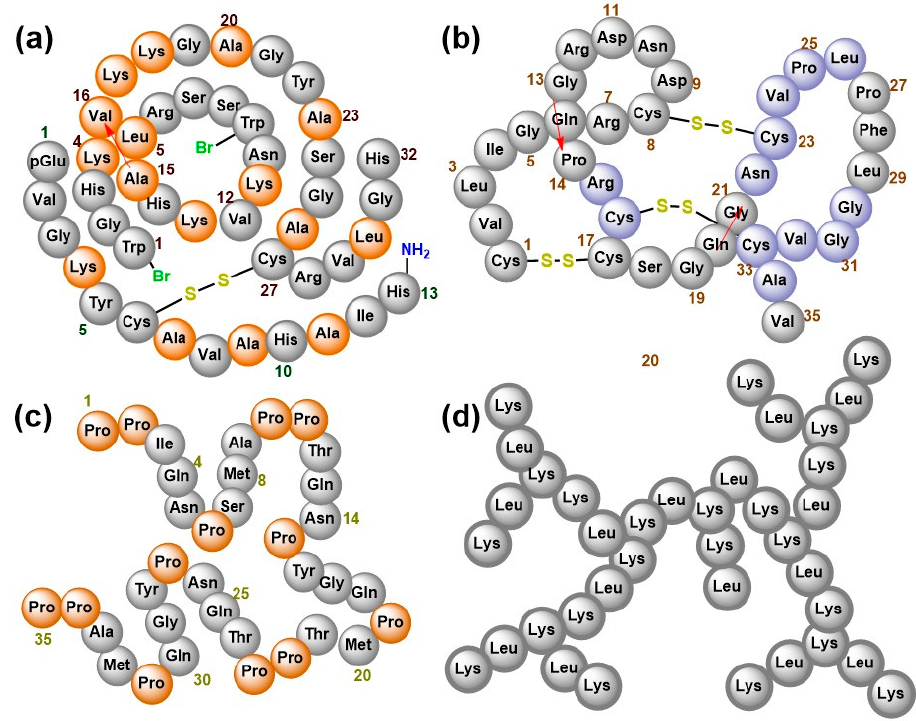
Figure 3. Diversified schematic structures of natural and artificial AMPs. ( a ) EeCentrocin 2 is an α -helical heterodimeric peptide with a heavy and a light chain connected via a disulfide bridge (helix-stabilizing residues are indicated in light brown). ( b ) EPrAMP1 has three disulfide bridges and three strands of beta-sheet (shown in violet). ( c ) BnPRP1 is a proline-rich peptide. ( d ) G3KL is a tree-like synthetic polymer composing of alternating residues of lysine and leucine. Red arrows indicate direction of crossing in the peptide chain.